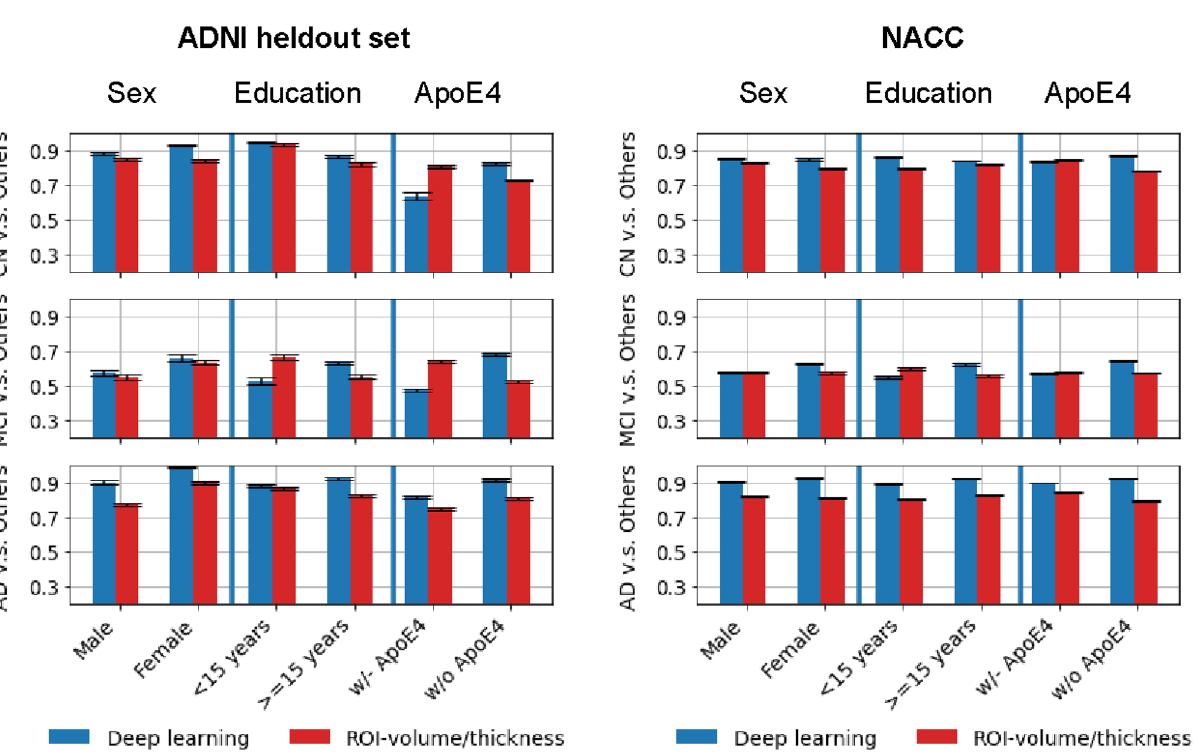
Figure 3. Performance across different subgroups. Performance of the deep learning model (in blue) and of the ROI-volume/thickness model (in red) for different subpopulations of individuals, separated according to sex, education, and ApoE4